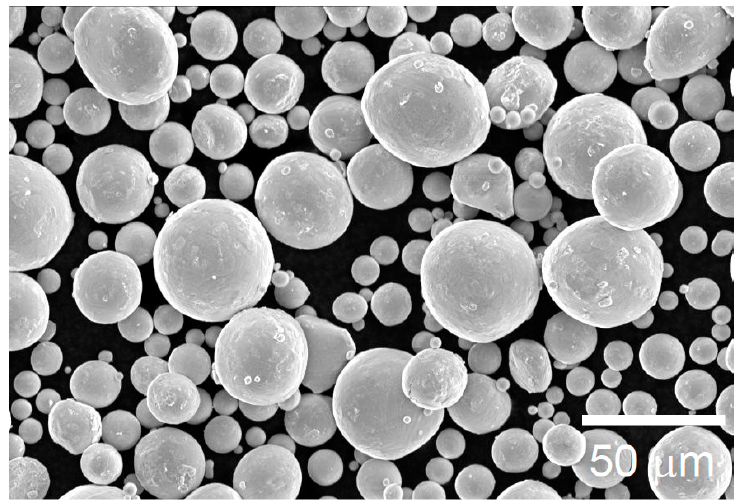
Figure 1. SEM (Scanning Electron Microscope) image of the Zr-1Mo powders used in this study. Table 1. The chemical composition of the gas-atomized Zr-1Mo powder.